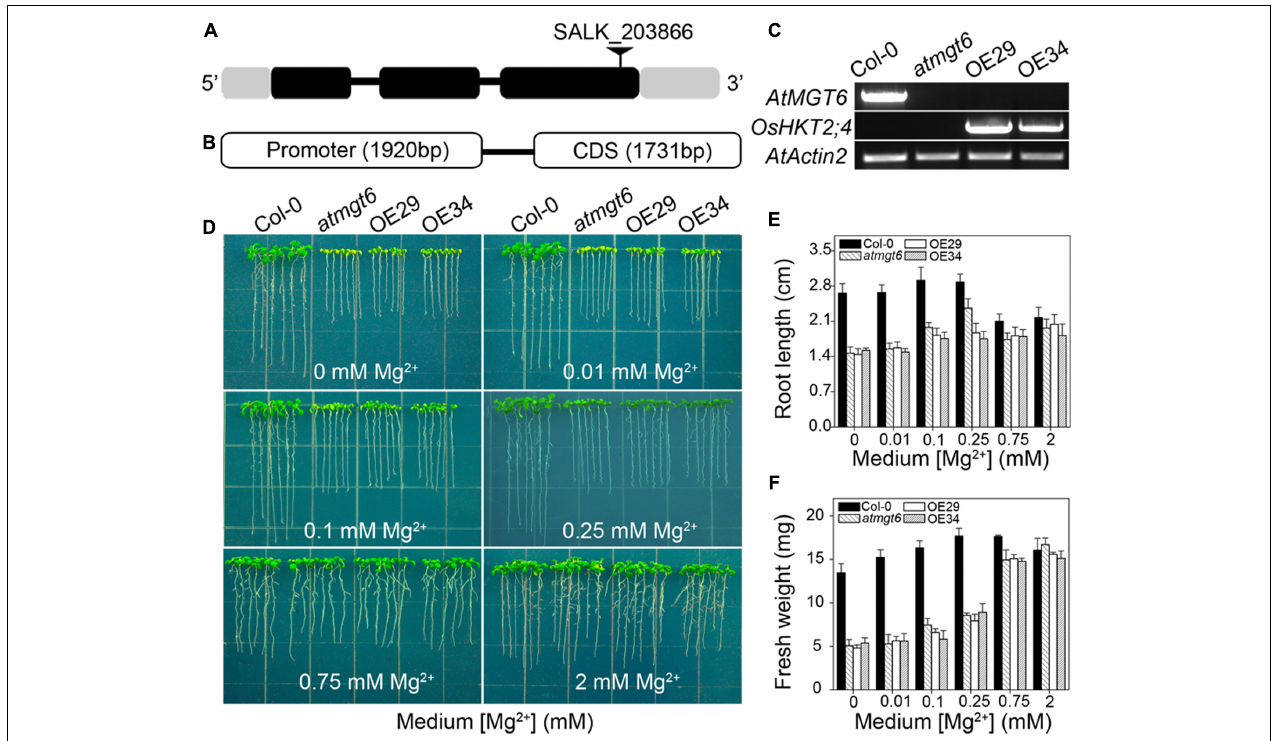
FIGURE 3 | Genetic characterization and phenotypic analysis of atmgt6 mutant lines and their OsHKT2;4 overexpressed lines in low-Mg 2 + conditions. (A) Scheme of AtMGT6 gene structure and position of the T-DNA insertion of SALK_203866. The gray boxes indicate 5 (cid:48) and 3 (cid:48) untranslated regions, and black boxes and lines indicate exons and introns, respectively. The T-DNA insertion is shown as the triangle above the gene diagram. (B) Gene fragment of OsHKT2;4 , including its promoter and CDS region that was introduced into atmgt6 lines. (C) Semi-quantitative mRNA levels of AtMGT6 and OsHKT2;4 by RT-PCR analysis in wild type (Col-0), AtMGT6 knockout mutant ( atmgt6 ), and two atmgt6 lines overexpressing OsHKT2;4 (OE29 and OE34). AtActin2 was used as the internal standard. (D) The growth of Col-0, atmgt6 , OE29, and OE34 under the Mg 2 + -deficient conditions. After planted in half-strength Murashige and Skoog (1/2 MS) medium for 3 days, Col-0, atmgt6 , OE29, and OE34 were transferred to one-sixth-strength MS (1/6 MS) medium containing 0, 0.01, 0.1, 0.25, 0.75, and 2 mM Mg 2 + in total, and were photographed after growing for 7 days. Quantitative analyses of primary root length (E) and whole-plant fresh weight (F) of Col-0, atmgt6 , OE29, and OE34 under the Mg 2 + -deficient conditions described in (D) . Six independent 10-day-old seedlings of each genotype were gathered as one biological repeat for root length and fresh weight measurement. Data are represented as the mean ± SD, n = 3, in which n is the number of biological